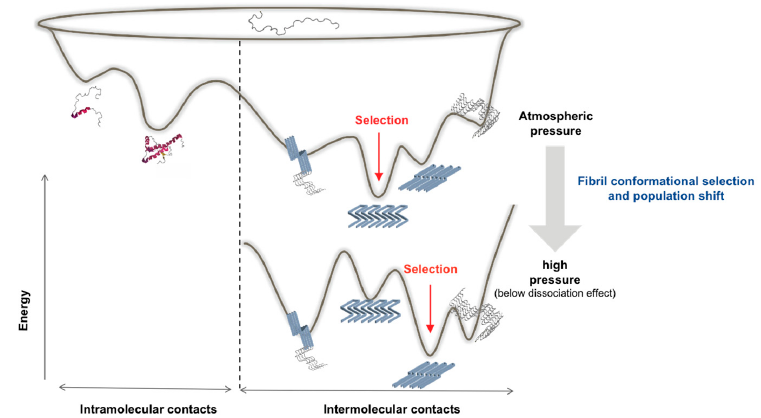
Figure 3. Schematic representation of a hypothetical effect of pressure on the energy landscape of an amyloidogenic protein. The conformational selection phenomenon assumes that the new thermodynamic condition reached under pressure will preferentially stabilize the amyloid state (i.e., conformation) with the highest packing density, resulting in a population shift of the ensemble toward the state showing the deepest energy minimum.